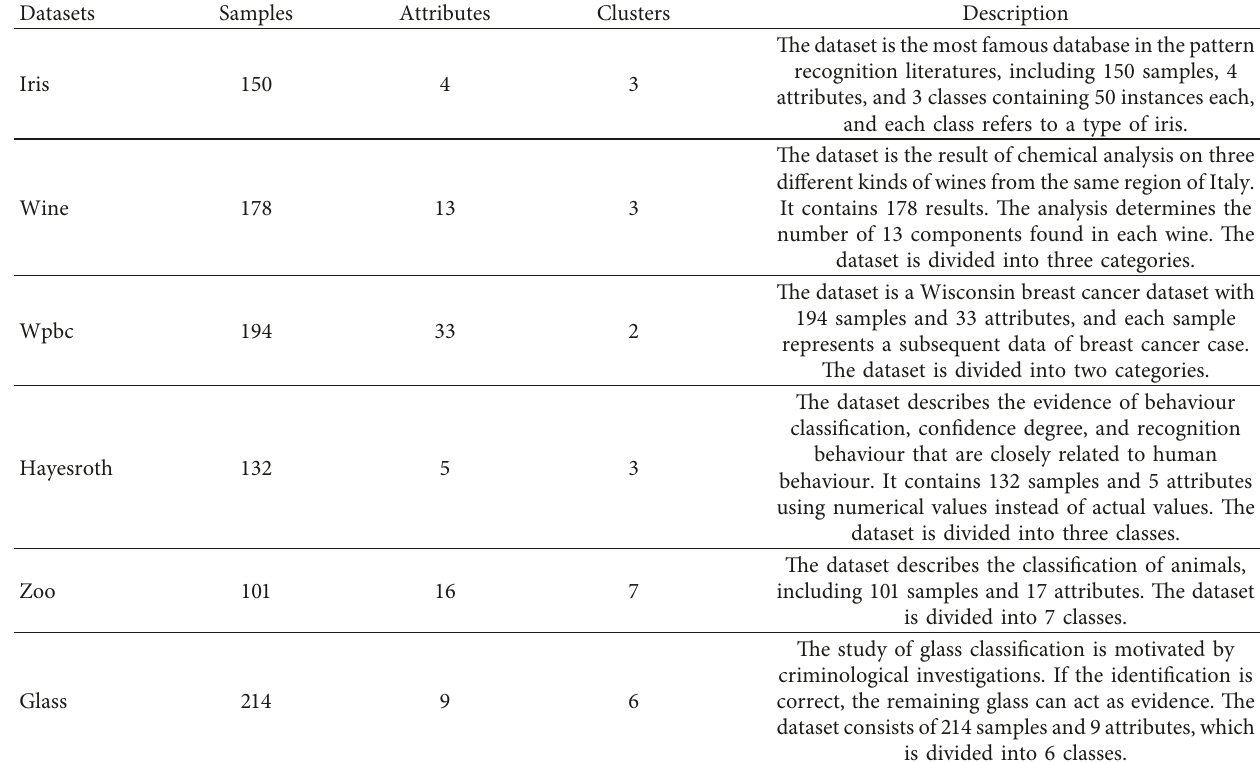
Table 2: The detailed information of